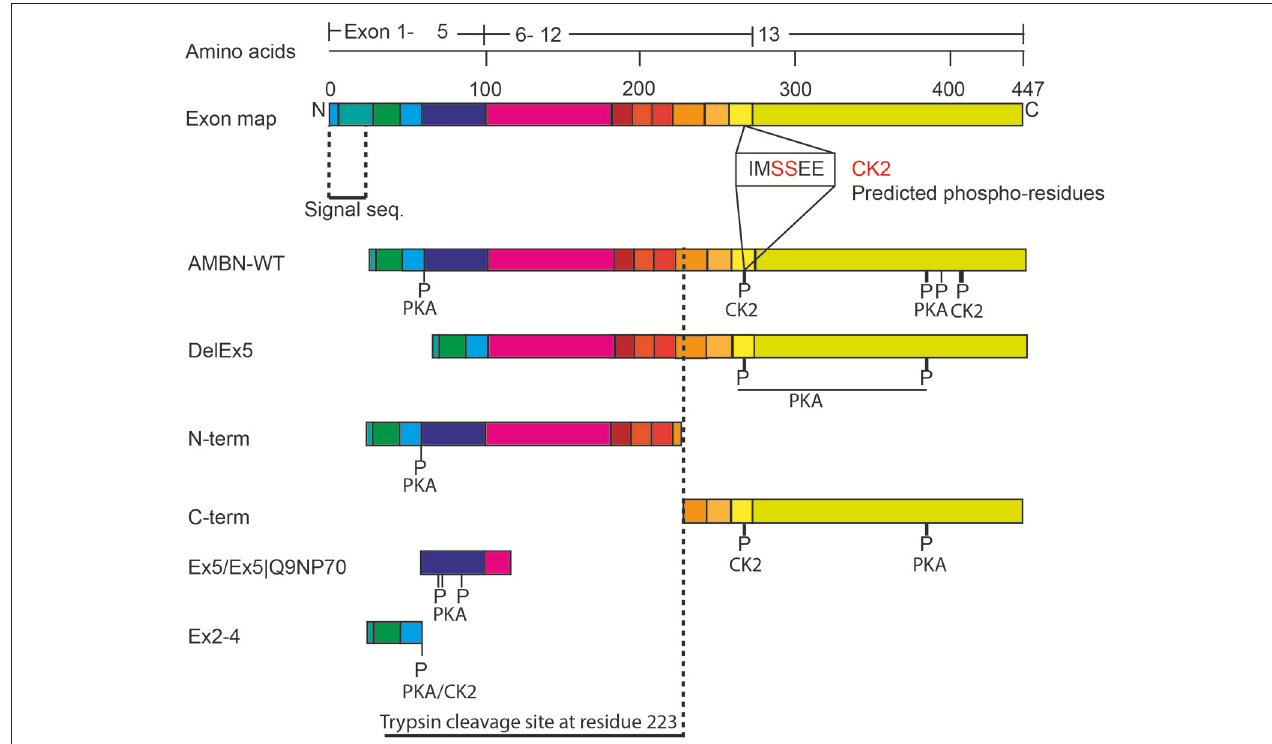
FIGURE 4 | Schematic overview of the phosphorylated sites in AMBN. The exon organization in relation to the various recombinant proteins and peptides are illustrated. P-indicate position of phosphorylated residues. The vertical dotted line indicates the known trypsin cleavage site between A222 and L223 ( Iwata et al.,